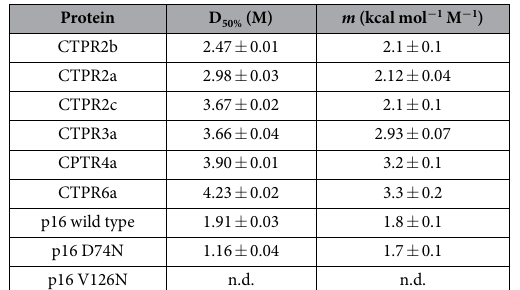
Table 1. Midpoints (D 50% ) and m -values for the denaturation data shown in Fig. 1, fitted to a two-state unfolding model. With the exception of CTPR2c, all experiments were performed in triplicate, and the errors listed are the standard errors of the mean. For CTPR2c the errors listed are the fitting errors on a single